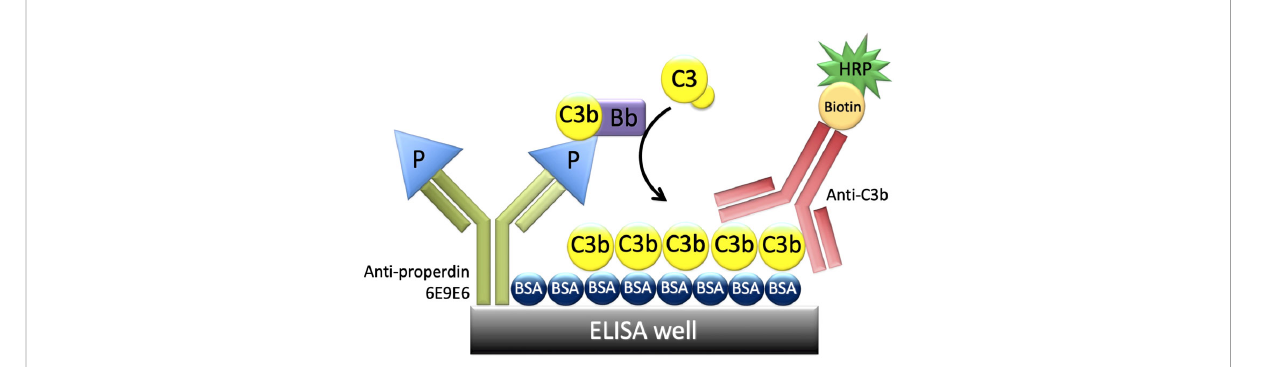
FIGURE 2 Principle of the properdin functional ELISA. An ELISA plate was coated with a non-inhibitory anti-properdin monoclonal antibody 6E9E6 (in green), blocked with BSA, and then properdin was captured from various sources (puri fi ed properdin, serum, neutrophil supernatant). The plate was washed, and properdin-depleted serum was added as a source of complement proteins including C3b, C3(H 2 O), Factor B, and Factor D. C3b or C3 (H 2 O) and Factor B bind to properdin to form C3 convertases, C3bBb, or C3(H 2 O)Bb. Convertases cleave C3 and C3b is deposited covalently on BSA and detected with biotin-labeled anti-C3b (in red) followed by horseradish peroxidase-streptavidin, resulting in a colorimetric